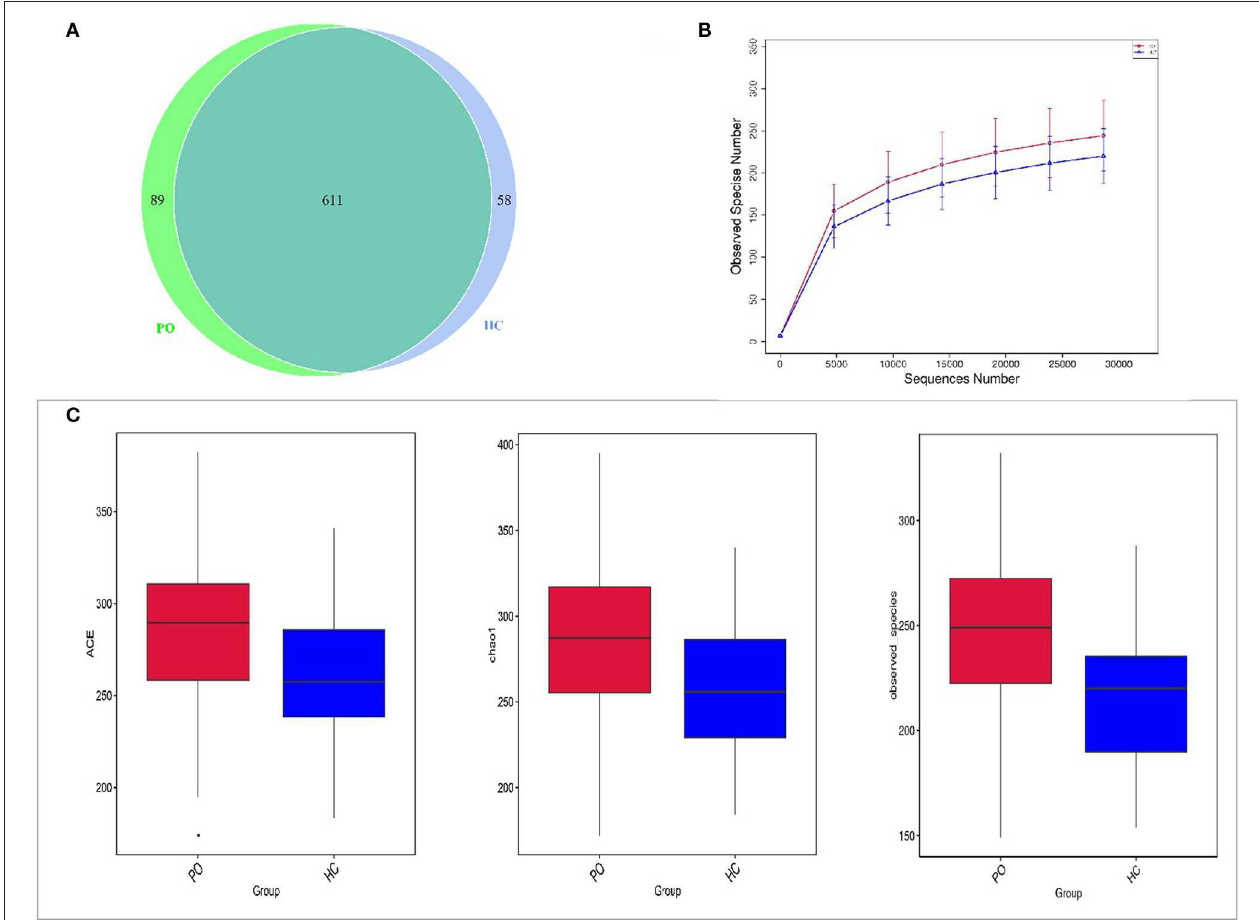
FIGURE 1 | Comparison of gut microbiome structure between PO and HC group. (A) Venn diagram: each circle in the figure represents a group, the number of overlapping parts represents the number of OTUs shared between the groups, and the number without overlapping parts represents the number of OTUs unique to the group. (B) Rarefaction Curve, Abscissa is the number of sequencing strips randomly selected from a sample, and ordinate is the number of OTU that can be constructed based on the number of sequencing strips, which is used to reflect the sequencing depth (Blue, HC; Red, PO). (C) The alpha diversity of the two groups of gut microbial communities was described according to the ACE, Chao1 and observed_species indices. Box plot reflects median, degree of dispersion, maximum, minimum, and outliers. P -values were determined using T -test and wilcox Rank Sum Test. HC, healthy control; PO, primary osteoporosis; OTU, operational taxonomic